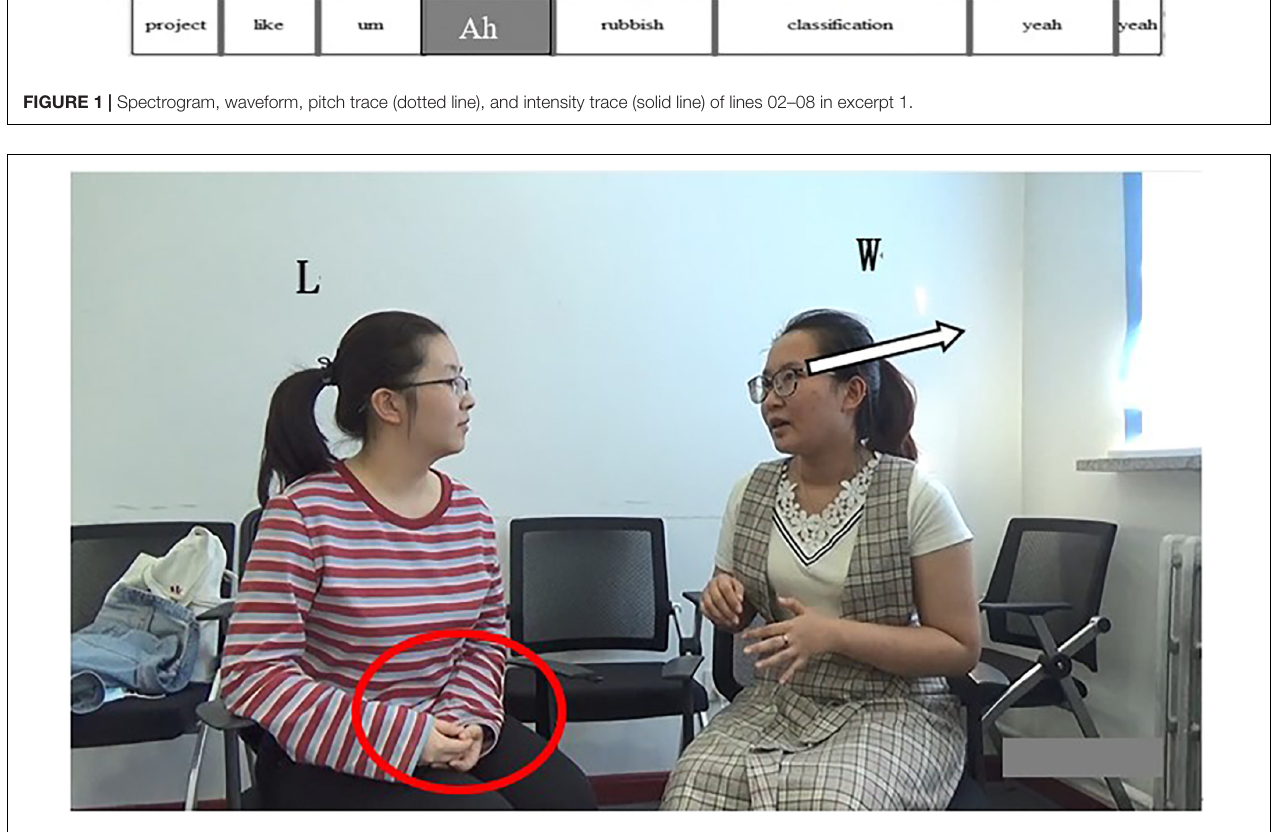
FIGURE 2 | Bodily movement of W in line